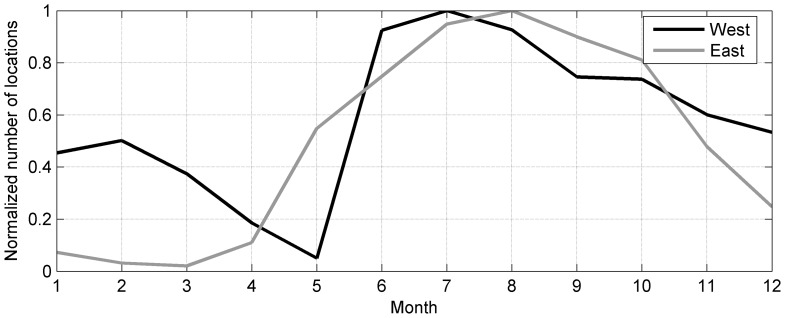
Seasonal distribution of telemetry data.Normalized number of received locations per month from SRDLs deployed on grey seals in the western (black) and eastern (grey) North Atlantic.